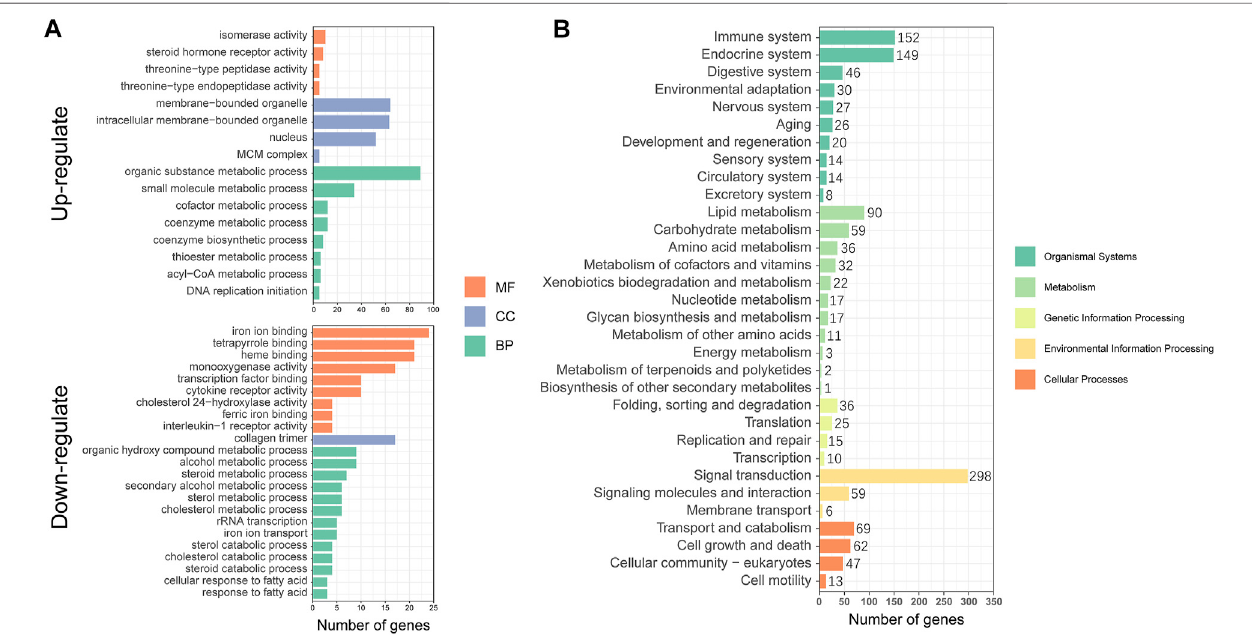
FIGURE 4 | Functional annotation and enrichment analysis of differentially expressed genes (DEGs): (A) Gene Ontology (GO) functional enrichment analysis; (B) Kyoto Encyclopedia of Genes and Genomes (KEGG) functional annotation analysis.